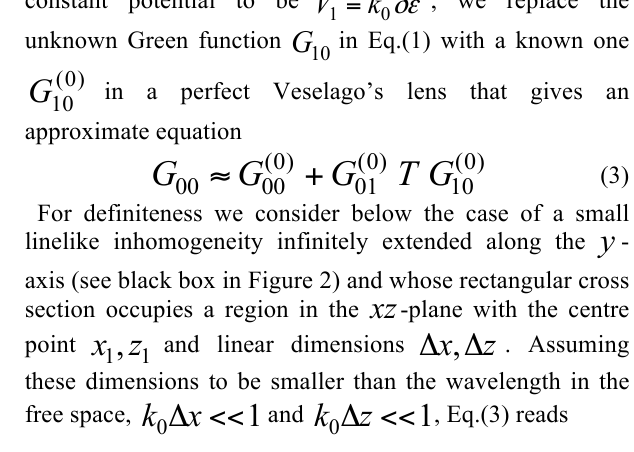
Figure 2: (a) Multiplicative effect in singularity transfer from the right outside plane zz ʹ′ = at some position Lz 20 < ʹ′ < to the left outside focal plane, )2( zLz ʹ′ −− = , by LHM slab via linelike scatterer source z ʹ′ , the real zLz ʹ′−→ 2